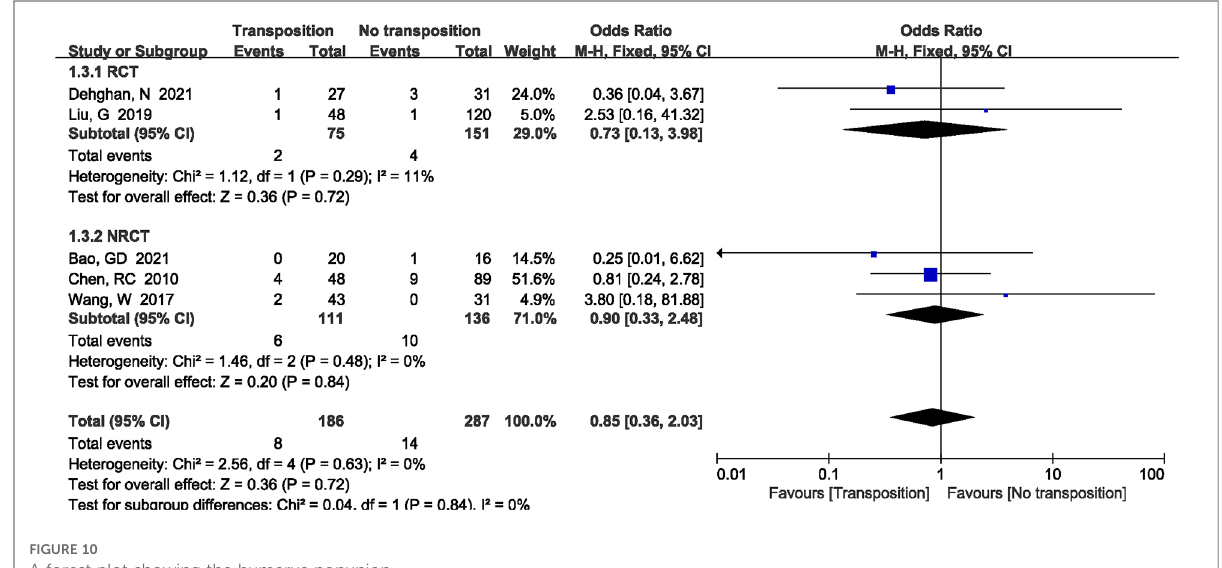
FIGURE 10 A forest plot showing the humerus nonunion.